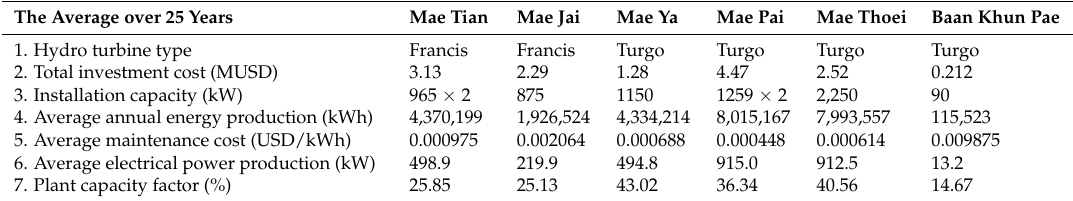
Table 2. The annual data for hydropower plants under Provincial Electricity Authority (PEA) supervision; Maintenance Production System Division